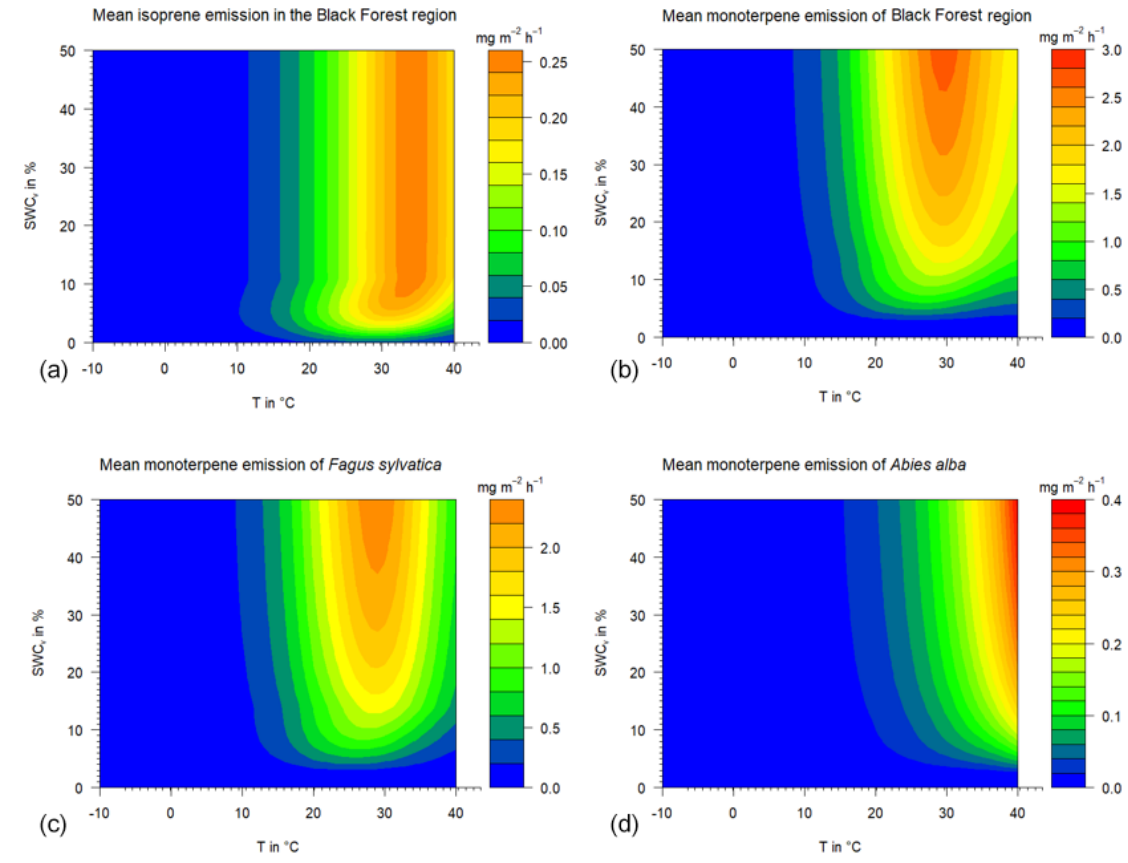
Figure 6. Calculated mean isoprene and monoterpene emissions under different temperature and drought stress conditions using the param- eterizations of Guenther et al. (2012) and the SWC dependency derived in this study. “Black Forest region” represents the forest inventory mean tree species mixture of the Black Forest area: (a) total isoprene emission, (b) total monoterpene emission, and baseline Fagus sylvatica and Abies alba MT emission rates ( c and d